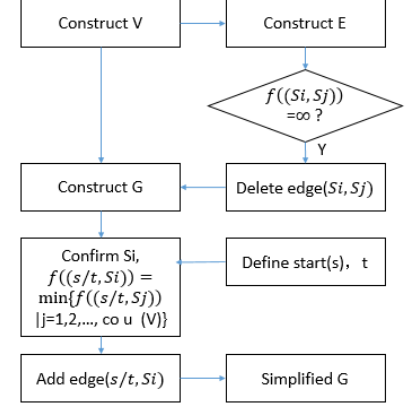
Fig.2 Building Procedure of Scenic Graph